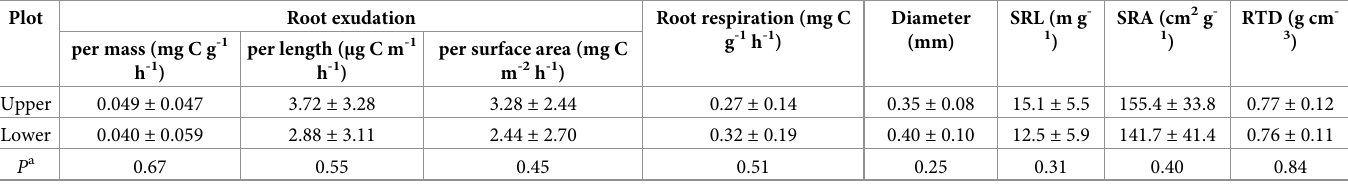
Values are shown as mean ± S.D. SRL, specific root length; SRA, specific root area; RTD, root tissue diversity. a Student t tests.